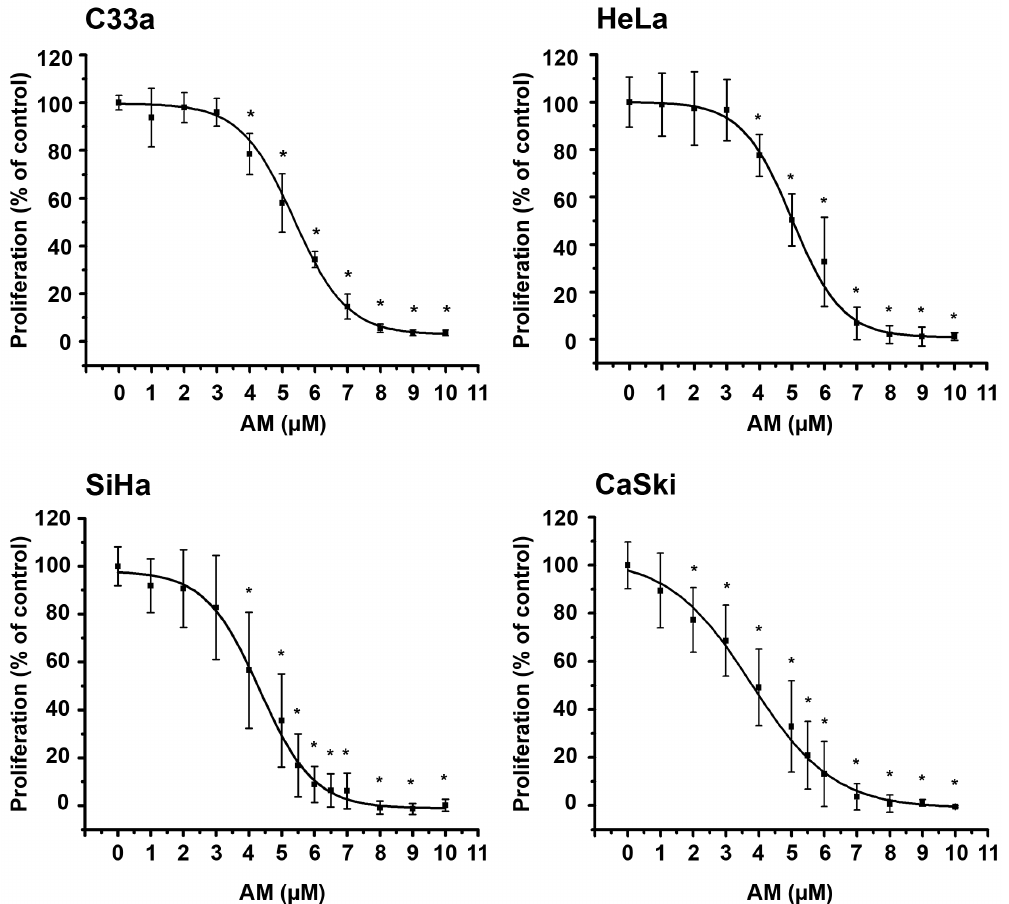
Figure 1. Effect of AM on cervical cancer cell proliferation. The antiproliferative effects of α - mangostin (AM) were tested in a panel of cervical cancer cells with different HPV viral load. The antiproliferative effect of AM was evaluated using a range of concentration from 1 to 10 µ M. The phytochemical significantly inhibited cancer cell proliferation in a concentration-dependent manner. Results are depicted as the mean ± SD of at least three independent experiments. The data from the vehicle-treated cells were normalized to 100%. * p < 0.05 vs. vehicle. Table 1. Cell proliferation IC 50 values of AM in cervical cell lines bearing different HPV viral